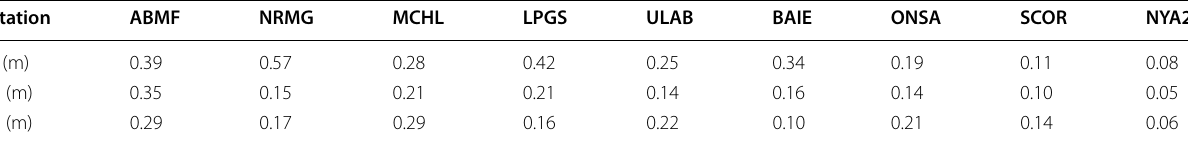
Table 3 RMSE of positioning errors at nine MGEX stations in static Doppler positioning Station